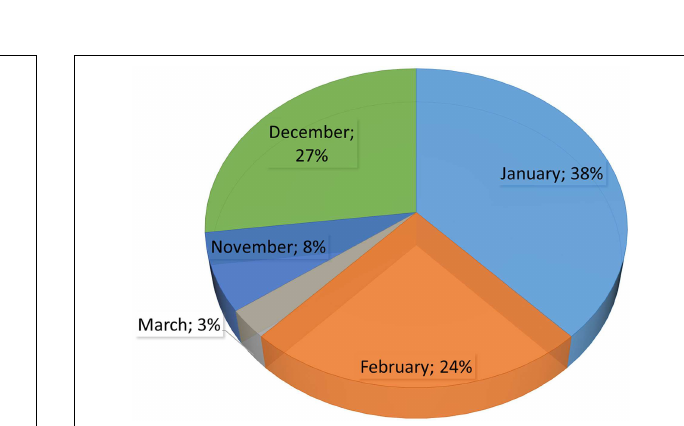
FIGURE 8 | Average precipitation in the method area, weighed by the number of events, during the 48 SACZ episodes for the LIB (orange) and PRE (green) series, and during the 73 episodes detected in the FUT series (violet).